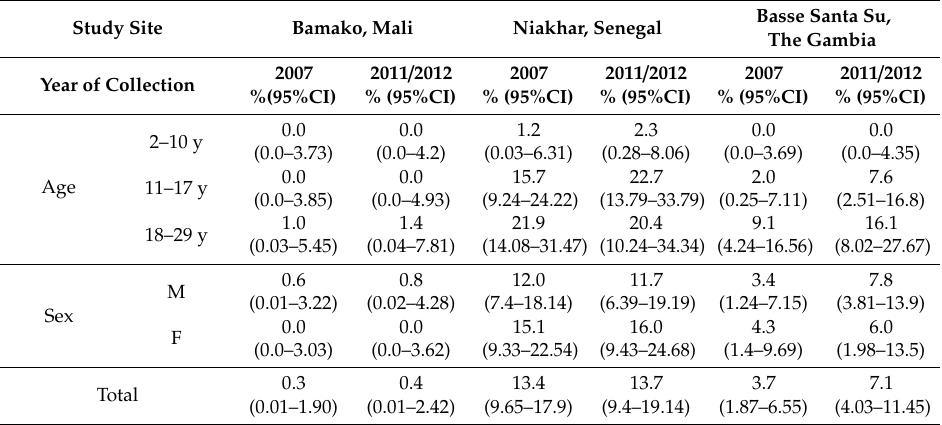
Table 2. Anti-ZIKV microneutralization test (MNT) antibody prevalence in 2007 and in 2011 / 2012 in Mali, Senegal and The Gambia, by age group and sex (%,